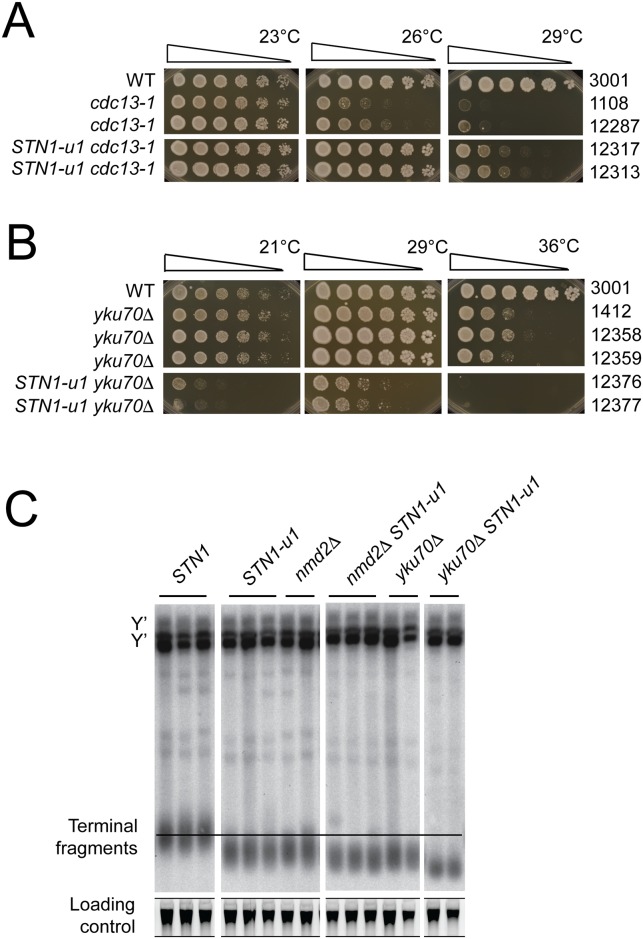
STN1-u1 improves fitness of cdc13-1 cells, decreases fitness of yku70Δ cells and causes short telomeres.A and B) Saturated cultures of the indicated strains were serially diluted, 5 fold, and spotted onto YEPD solid media and incubated for two days at indicated temperatures before being photographed. C) Genomic DNA was isolated from the yeast strains indicated, and telomere structures were analyzed by Southern blotting using a Y′ and TG probe, using SYBR Safe as a loading control, as previously described [26]. The image is cropped from a single membrane.